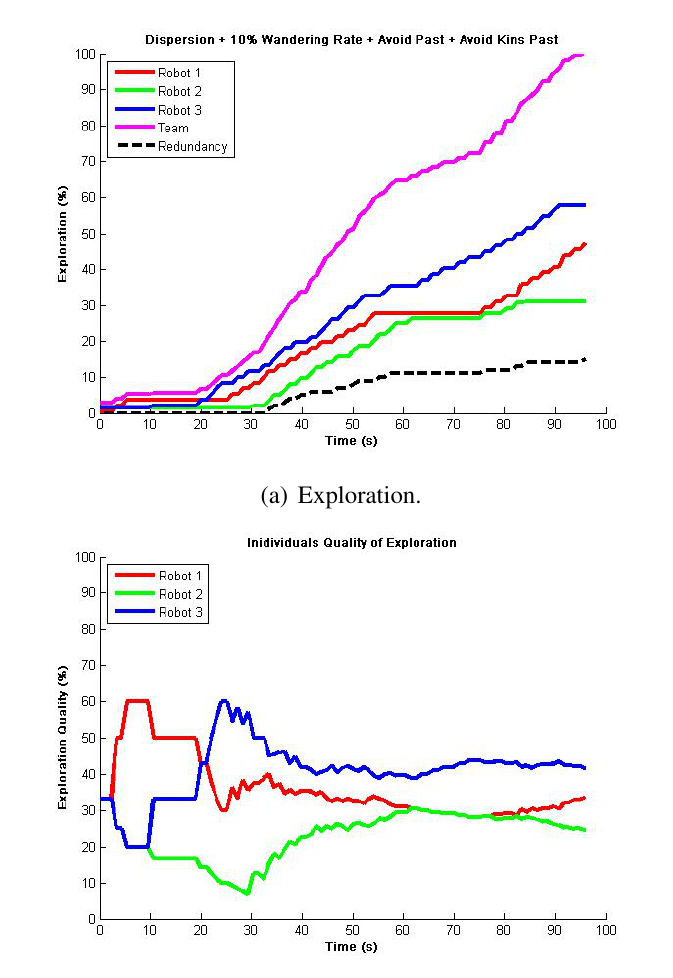
Figure 7. Autonomous exploration showing representative results in a single run for 3 robots avoiding their own and teammates’ past. Results show more interference and imbalance at exploration quality when compared to avoiding their own past only.